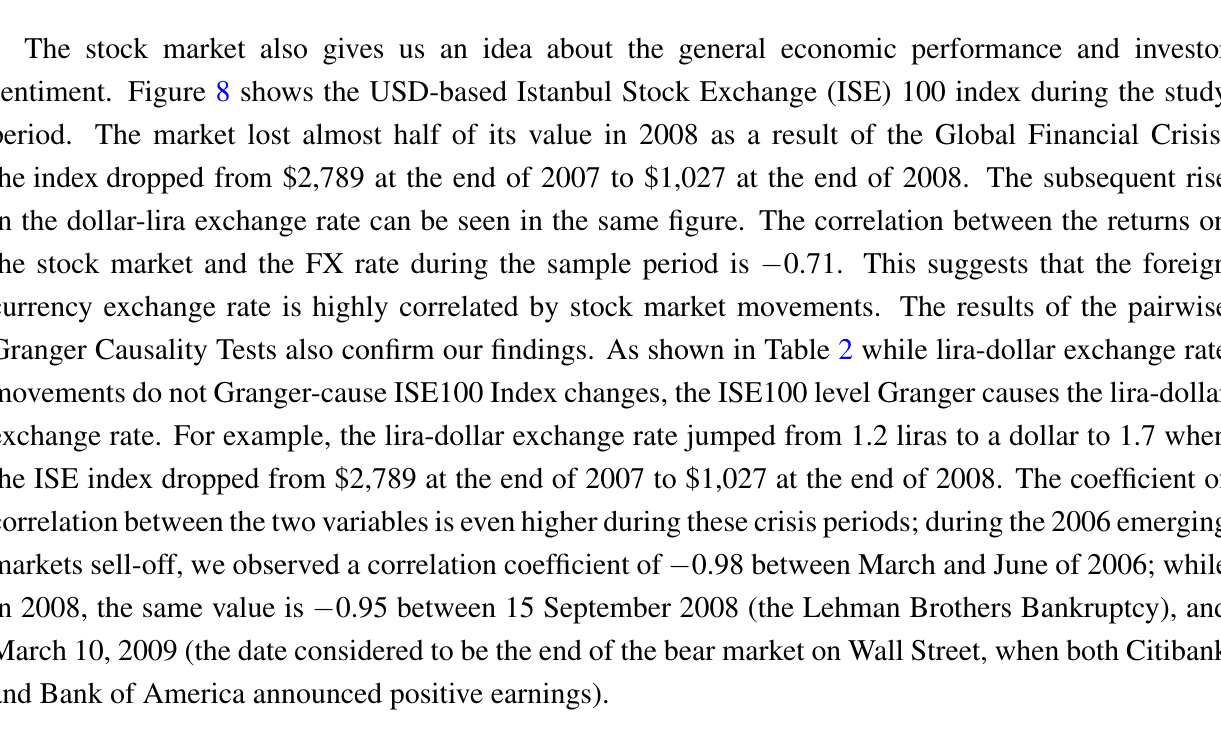
Figure 8. Istanbul Stock Exchange (ISE)100 USD-based